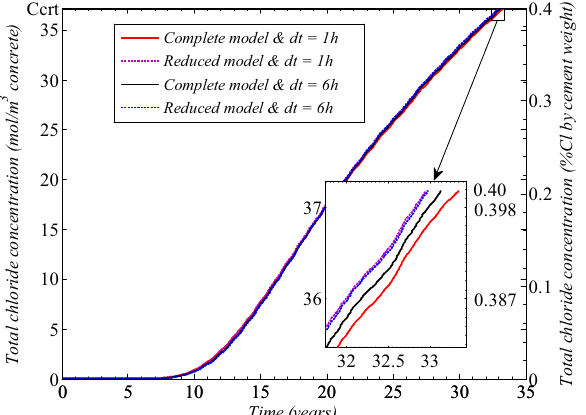
Fig. 6 Comparison of models considering various time-steps for a RC structure in a tidal zone (Brest,